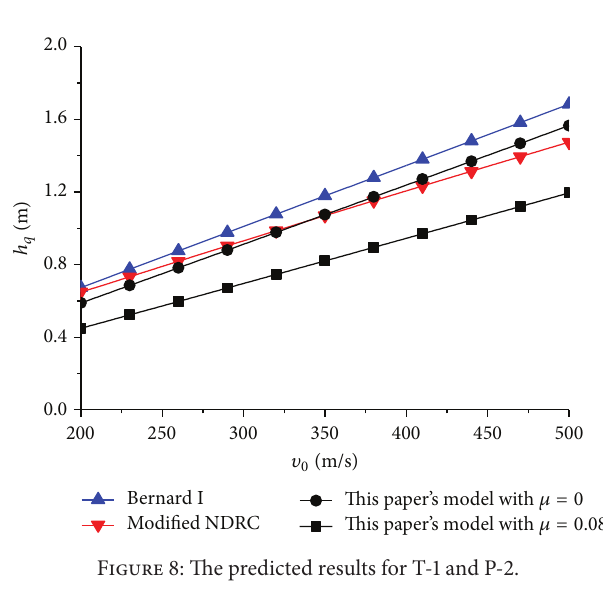
Figure 8: The predicted results for T-1 and P-2.